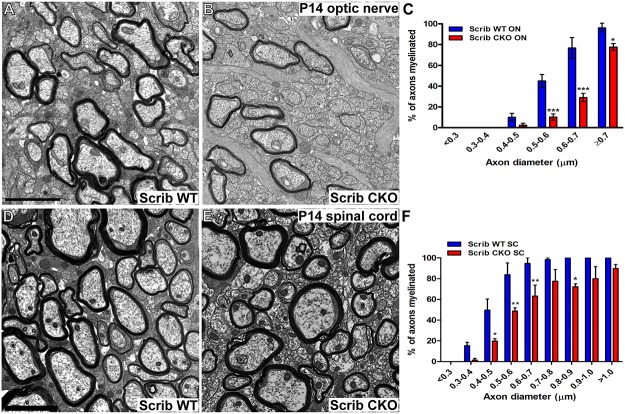
Scribble is required for normal myelin initiation in vivo.A–C; Fewer myelinated axons were observed in P14 optic nerve cross-sections from Scribble conditional knock-out (B) relative to wild-type controls (A). This was observed in axons of all diameters (C; 0.5–0.6 μm: WT = 45.1% ± 6.2%, cKO = 10.3% ± 3.0% myelinated; 0.6–0.7 μm: WT = 76.9% ± 9.9%, cKO = 29.0% ± 4.1% myelinated; ≥0.7 μm: WT = 96.1% ± 3.8%, cKO = 77.7% ± 3.2% myelinated). D–F; Fewer myelinated axons were also observed in P14 spinal cord cross-sections from Scrib cKO (E) relative to wild-type controls (D) for all but the largest-diameter axons (F; 0.4–0.5 μm: WT = 49.7% ± 10.6%, cKO = 19.7% ± 2.3% myelinated; 0.5–0.6 μm: WT = 83.7% ± 11.5%, cKO = 48.7% ± 3.1% myelinated; 0.6–0.7 μm: WT = 94.7% ± 5.3%, cKO = 63.1% ± 10.7% myelinated; 0.8–0.9 μm: WT = 100% ± 0%, cKO = 72.2% ± 2.8% myelinated). Numerical results are presented as mean ± SEM. Two-way ANOVA with Bonferroni's multiple comparisons test was used. n = 3 mice per genotype. At least 200 axons analysed per region, per mouse. * p < 0.05, ** p < 0.01, *** p < 0.005 versus Scrib WT. Scale bars in A,E = 2μm.